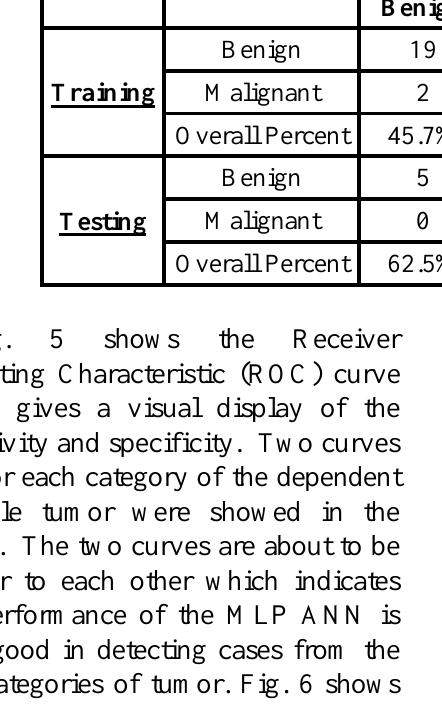
Table 4: Cross classification of used cases with respect to categories of tumor. Sample